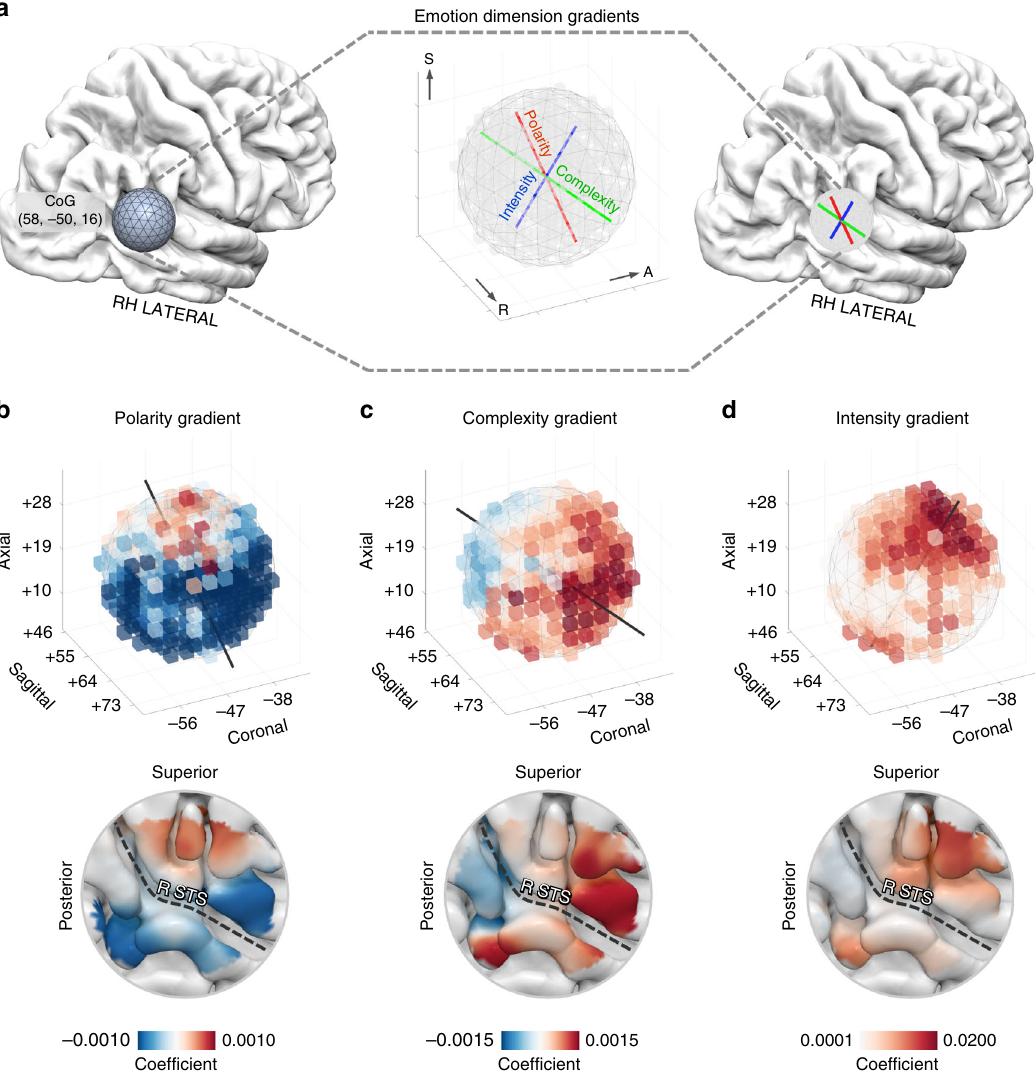
Fig. 4 Emotion gradients in right TPJ. a We revealed three orthogonal and spatially overlapping emotion dimension gradients (polarity, complexity and intensity) within a region of interest located at the reverse inference peak for the term TPJ (15 mm radius sphere). Symmetry axis of the region of interest represents the main direction of the three gradients. b β coef fi cients of the polarity dimension are mapped in an inferior to superior direction. c β coef fi cients of the complexity dimension are mapped in a posterior to anterior direction. d β coef fi cients of the intensity dimension are mapped in an inferior to superior direction. For single-subjects results, please refer to Supplementary Fig. 3. Lowermost row depicts the arrangement of the emotion dimension gradients in surface space. CoG center of gravity, R STS right superior temporal